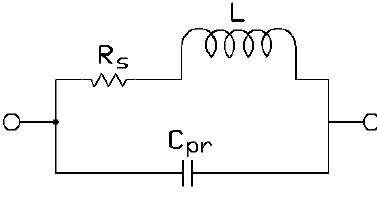
Figure 5. Resonator lumped model.